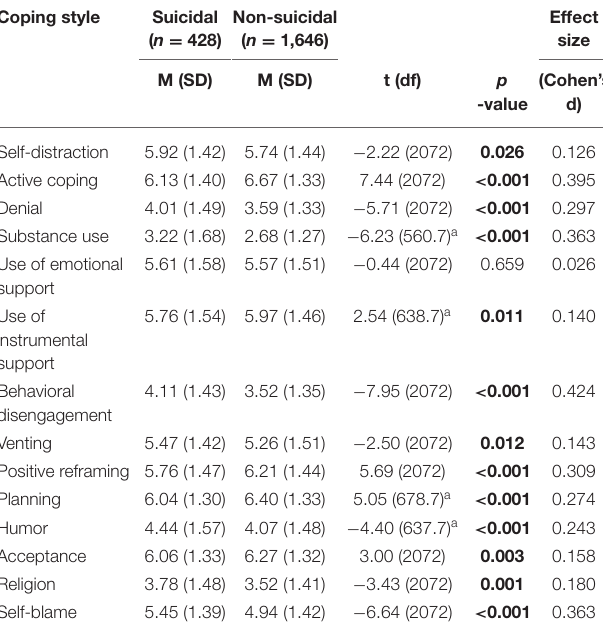
TABLE 2 | Suicidal and non-suicidal group by copying styles (as per the Brief COPE Scale). Coping